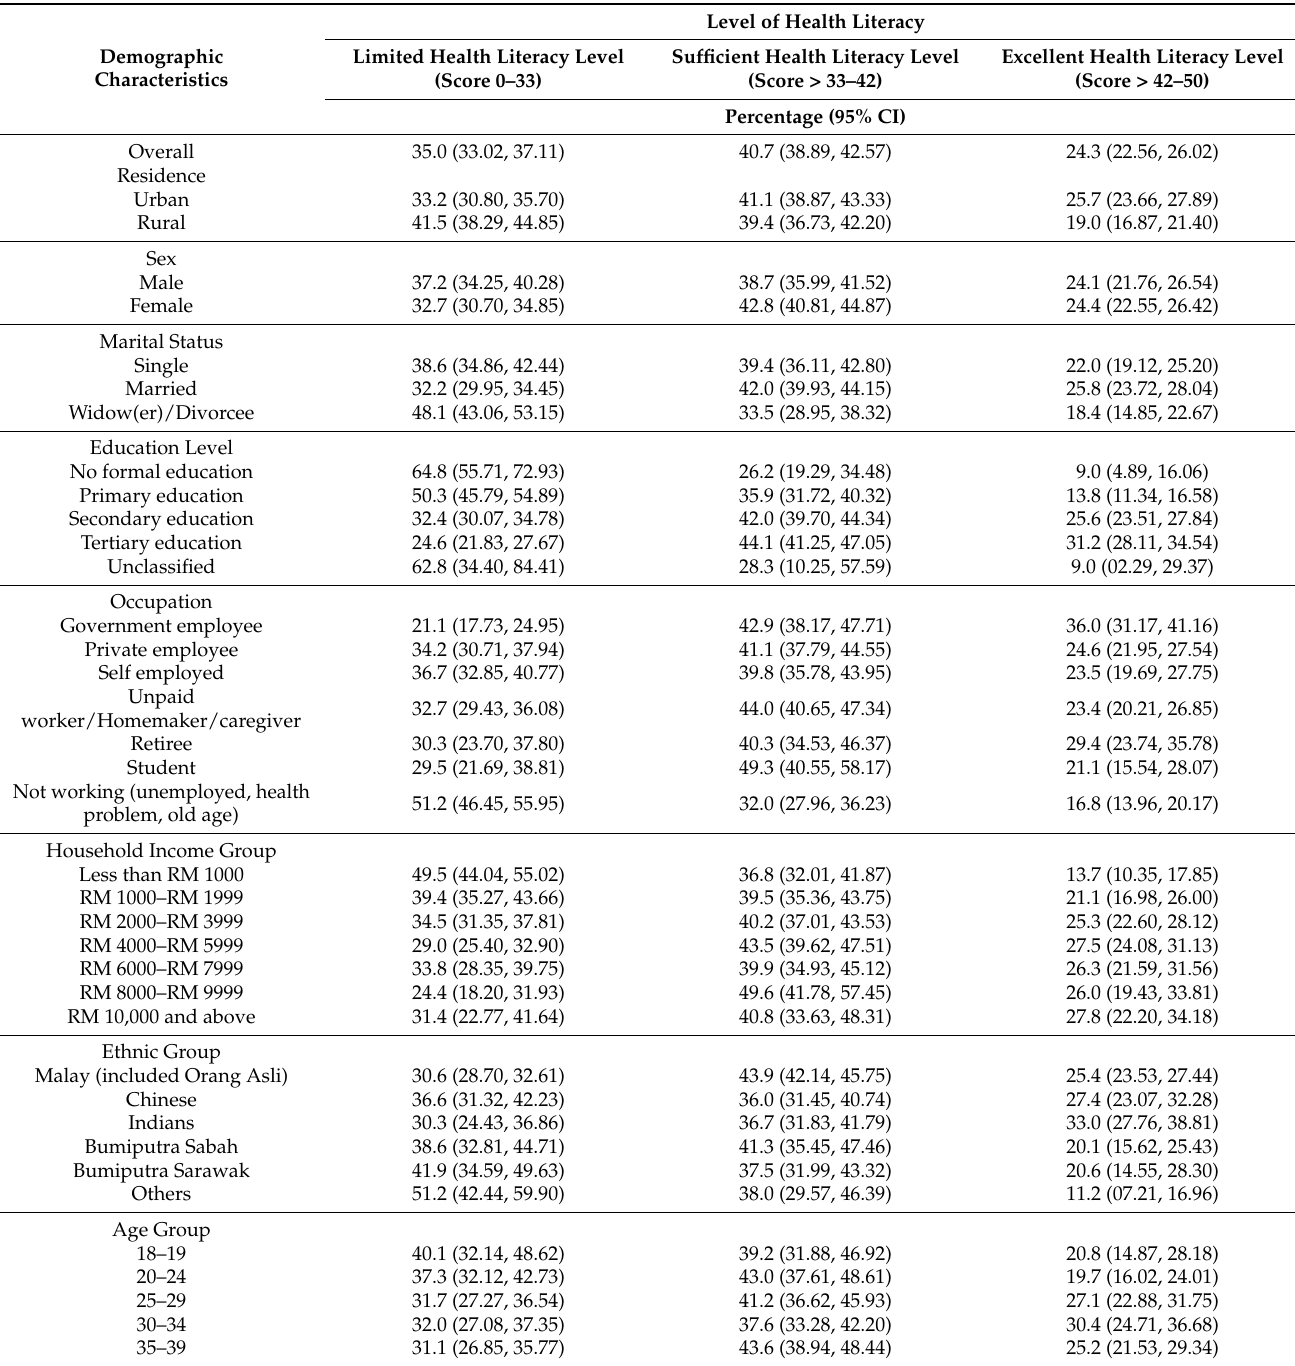
Table 1. Descriptive statistics of general health literacy level by socio-demographic